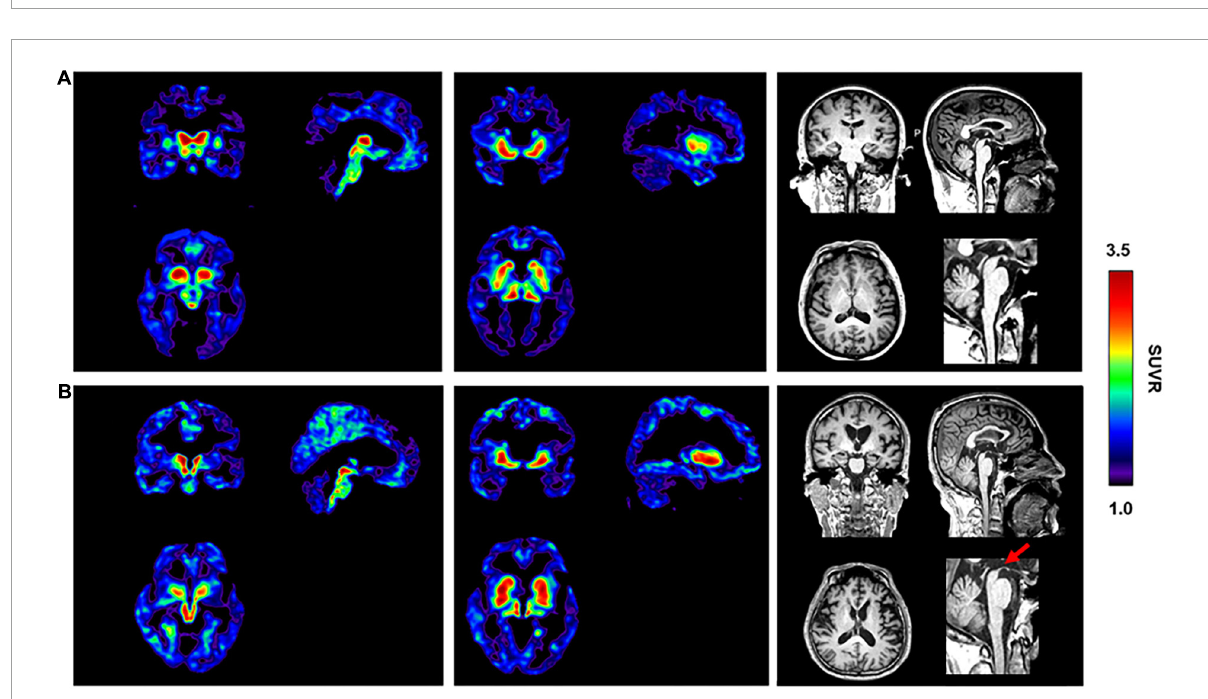
FIGURE4 [ 18 F]-S16 retention in an elderly healthy control [male, MMSE = 30, (A) ] and a patient with progressive supranuclear palsy [male, MMSE = 18, PSP, (B) ]. Transverse, sagittal and coronal sections of [ 18 F]-S16 PET SUVR images were observed with considerable radioactive retention in the midbrain and basal ganglia. The typical “hummingbird sign” was detected on the sagittal T1 weighted image of the patient (red